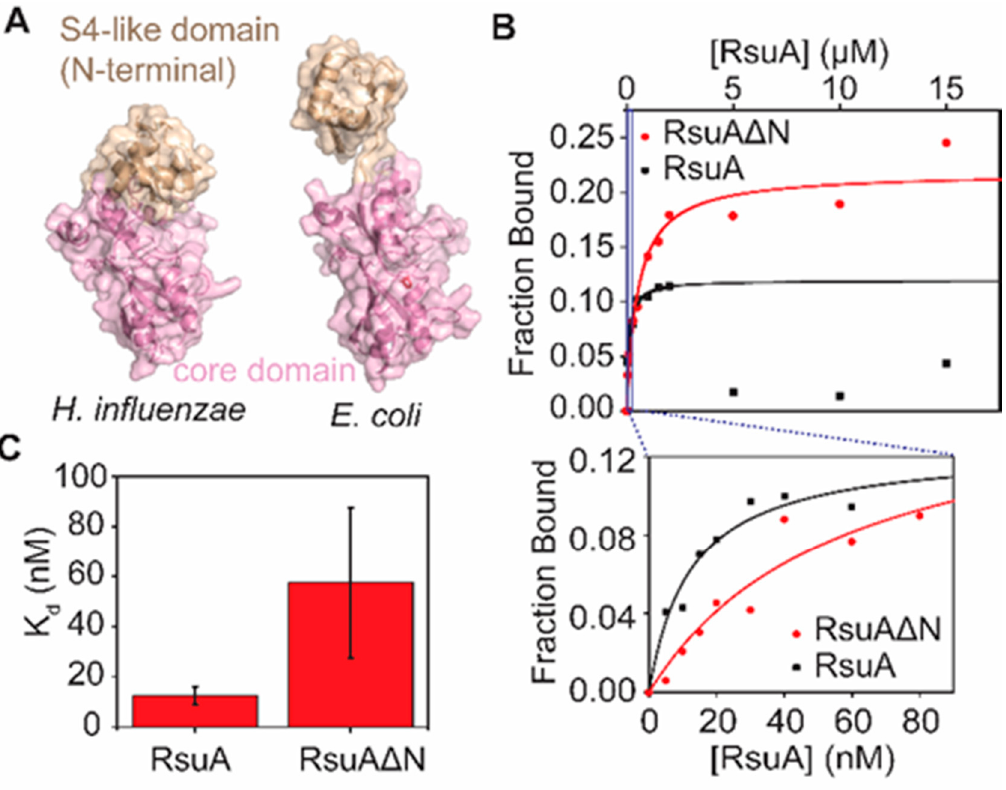
Figure 5. The S4-like domain of protein RsuA helps protein RsuA to bind with rRNA. ( A ) X-ray crystal structures of Haemophilus influenzae and Escherichia coli RsuA. RsuA S4-like domain and core domains are shown in wheat and pink, respectively. ( B ) Binding isotherms obtained for RsuA Δ N (red circles) and wild type RsuA (black squares) from filter binding assays are shown. For wild type RsuA, the bound fraction decreased at concentrations higher than 2 µM, perhaps due to dimerization of wild type RsuA. Black (wild type RsuA) and red (RsuA Δ N) lines represent least-square fitting for 0–2 µM and 0–15 µM range, respectively. ( C ) Binding affinities of wild type RsuA and S4-like domain truncated RsuA Δ N to the 30S 5 ′ -domain. The average of three replicates is shown. The error bars represent propagated errors.